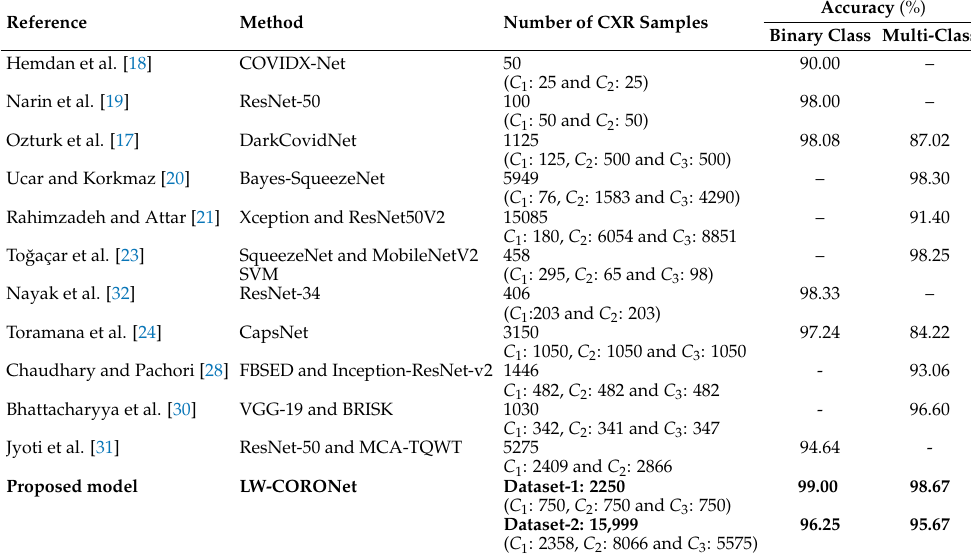
Table 11. Comparison of proposed model with existing COVID-19 detection